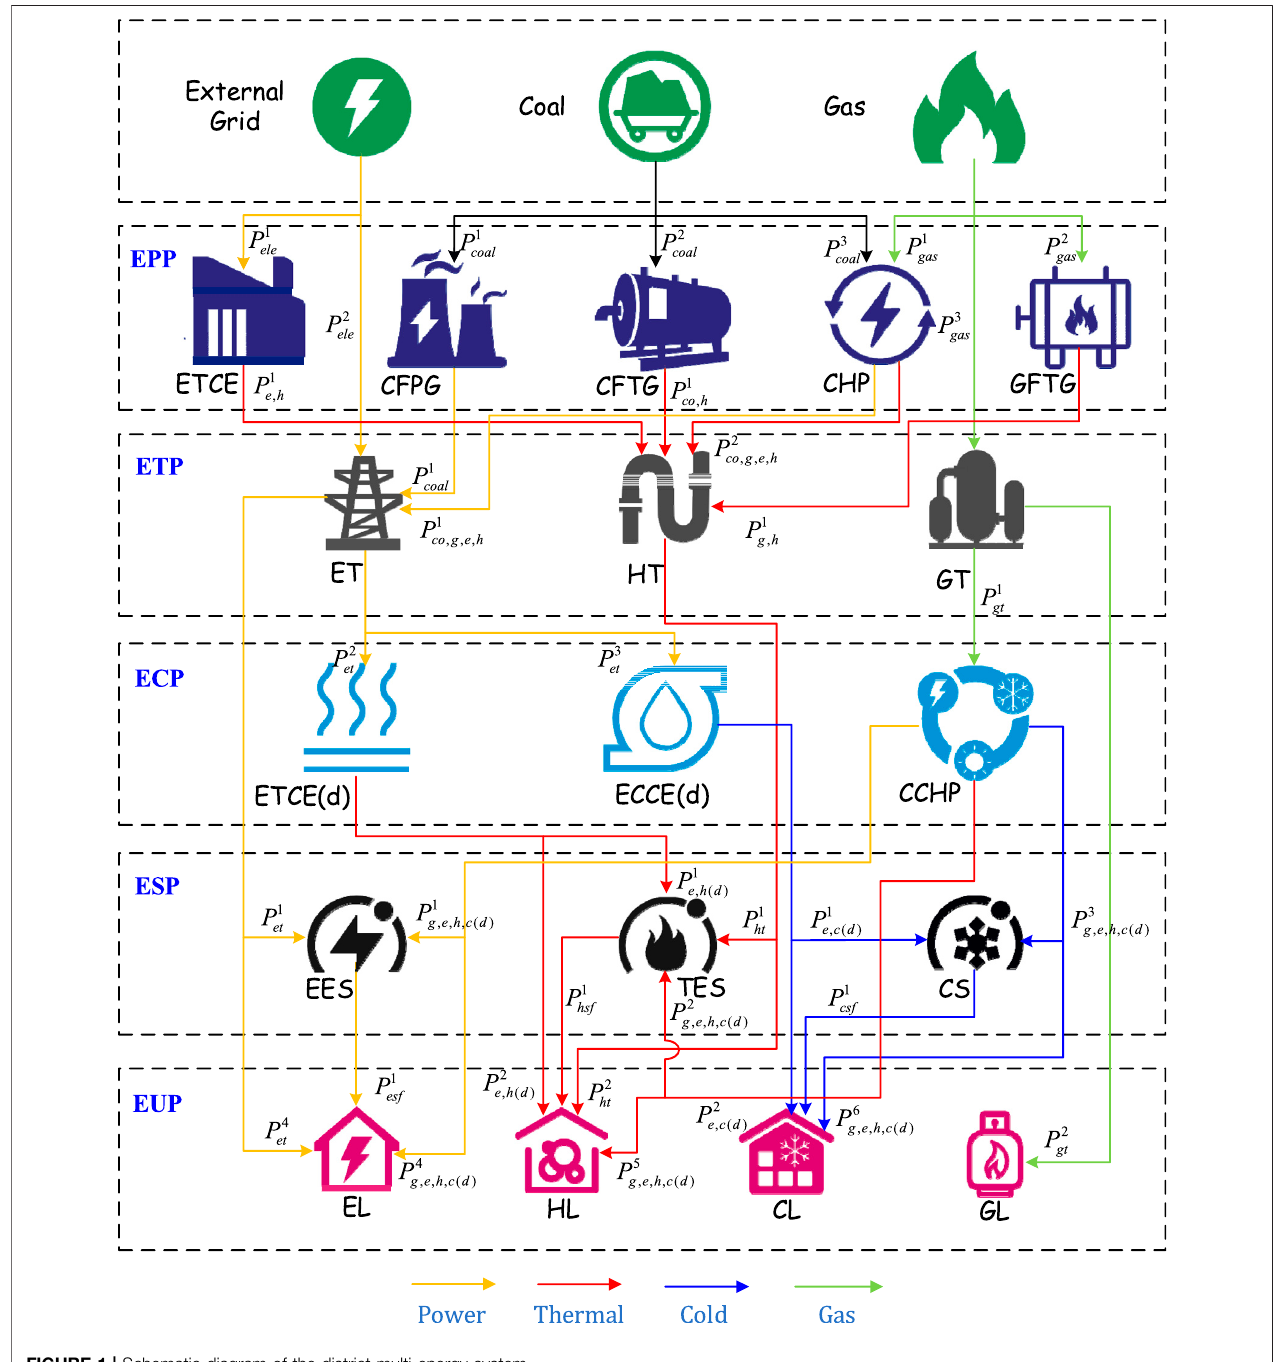
FIGURE 1 | Schematic diagram of the district multi-energy